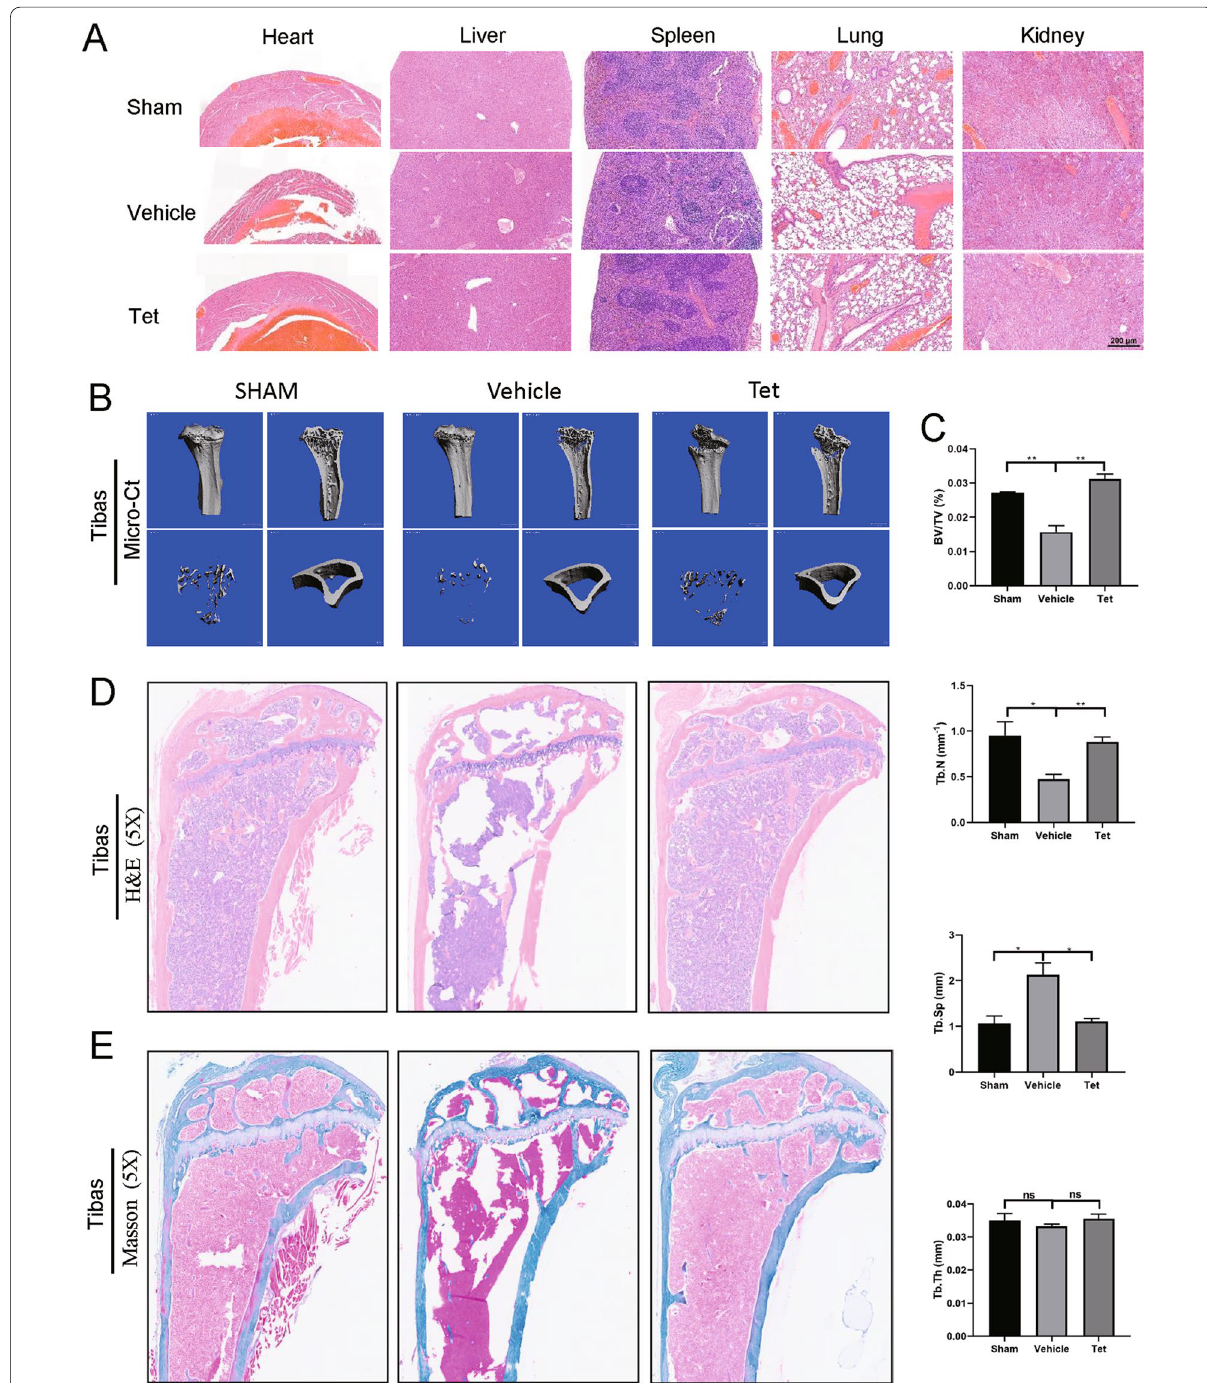
Fig. 9 Tetrandrine inhibits OVX-induced osteoporosis in mice model. A H&E staining was used for several major organs of mice in three groups (each; n 5). B , C The micro-CT was used for the scanning tibias of each mouse, and the BS/BV, Tb.N, Tb.Sp and Tb.Th values were recorded for each = specimen. D , E H&E and Masson staining was also used for the femurs. All experiments were carried out in triplicate. The results were presented as mean SEM. * P < 0.05 and ** P < 0.01 as compared with the control ±